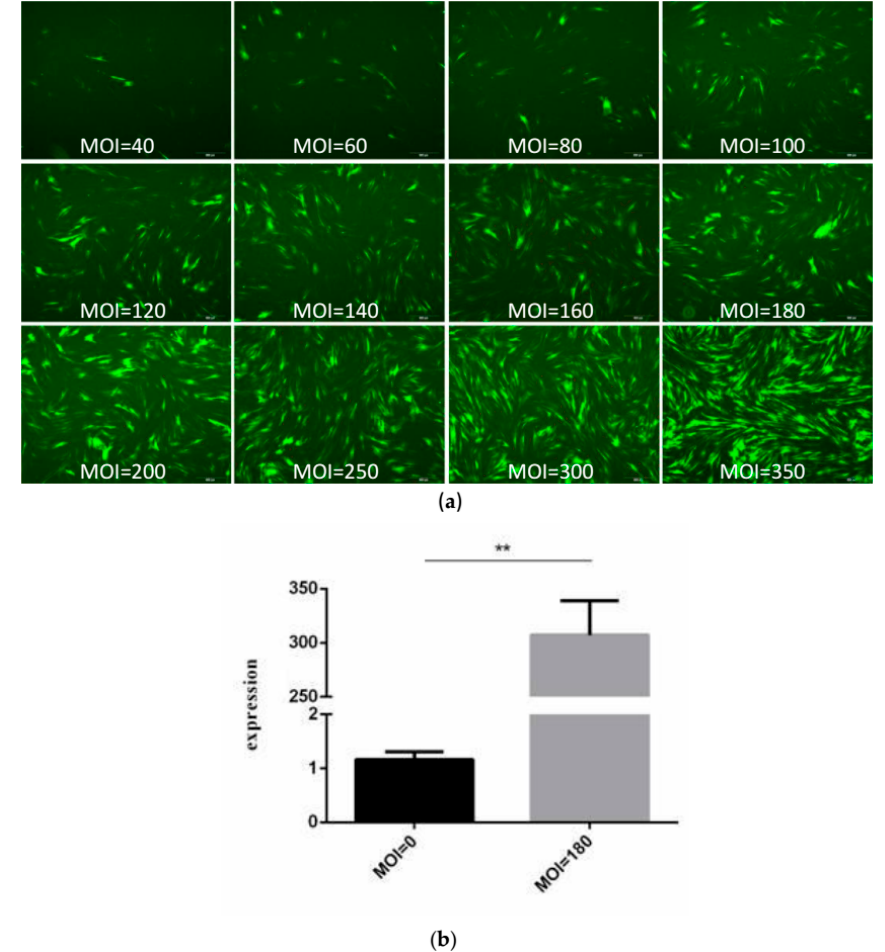
Figure 1. Determination of recombinant adenovirus multiplicity of infection (MOI) value. ( a ) Different MOI values 72 h after Rybp adenovirus (pAd-Rybp) infection of bovine myoblast (40× magnification); ( b ) the expression of the Rybp gene in myoblasts with 0 and 180 MOI of pAd-Rybp. (** p < 0.01).